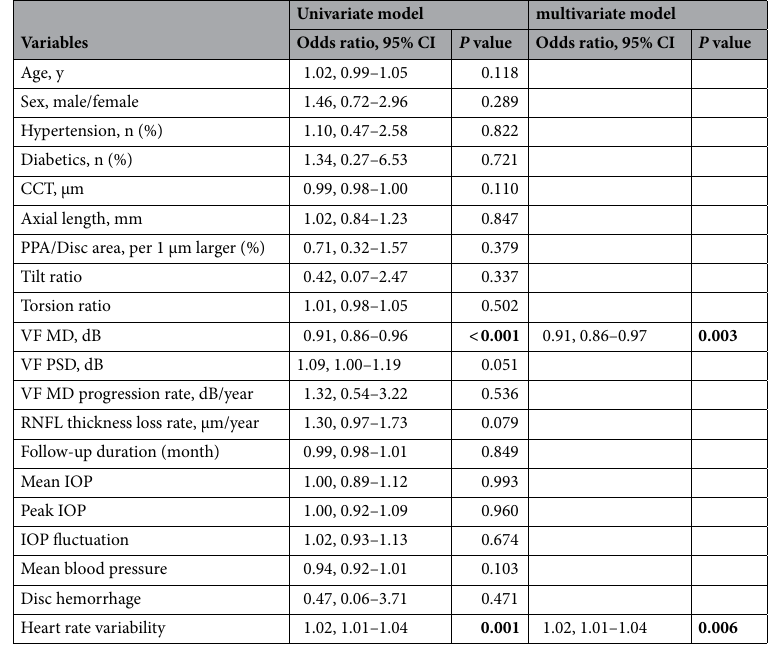
Table 6. Factors associated with the Beck Depression Inventory (BDI-II) scale in patients with glaucoma. CI, confidence interval; CCT, central corneal thickness; PPA, peripapillary atrophy; VF, visual field; MD, mean deviation; PSD, pattern standard deviation; RNFL, retinal nerve fiber layer; IOP, intraocular pressure. Variables with p < 0.05 were included in the multivariate analysis. Statistically significant values appear in boldface. Continuous data are mean ± mean standard deviation unless otherwise indicated.